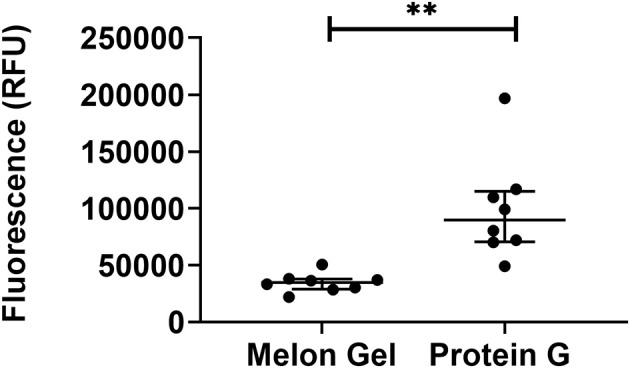
Low-pH buffer exposure of IgG results in an enhanced hydrophobic effect. Median + IQR fluorescence intensity of 32 μM ANS in the presence 2 μM of n = 8 matched purified Melon Gel and Protein G samples.